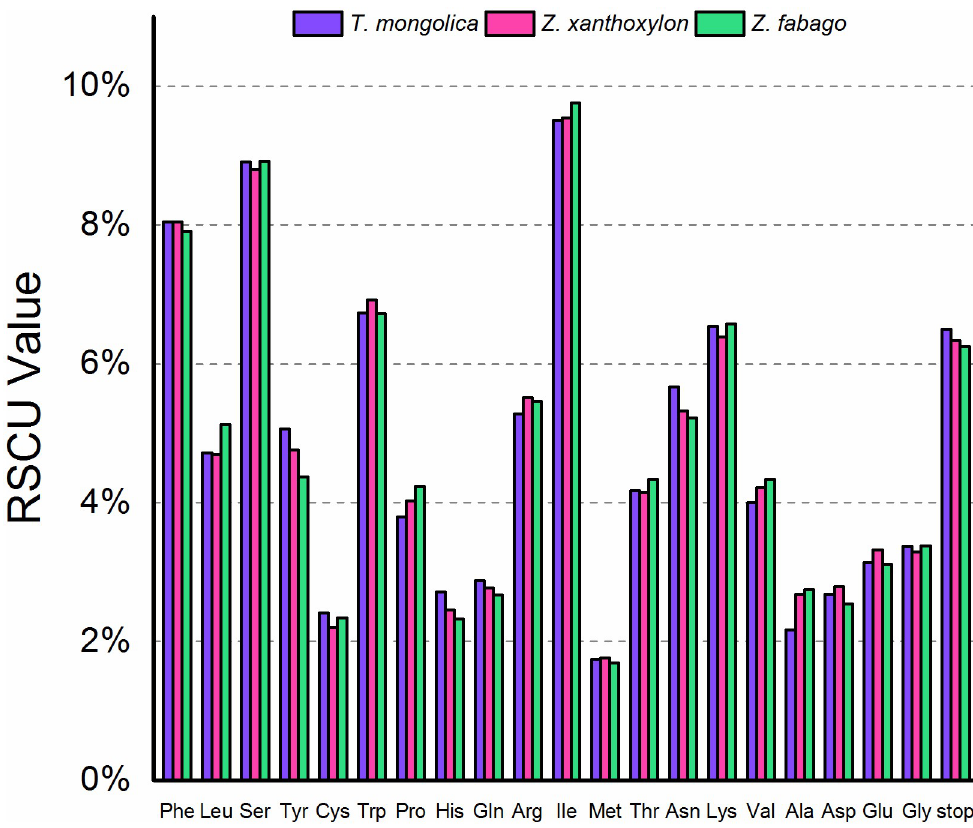
Fig 5. Proportion of codon preference in chloroplast genome of T . mongolica , Z . xanthoxylon and Z . fabago .